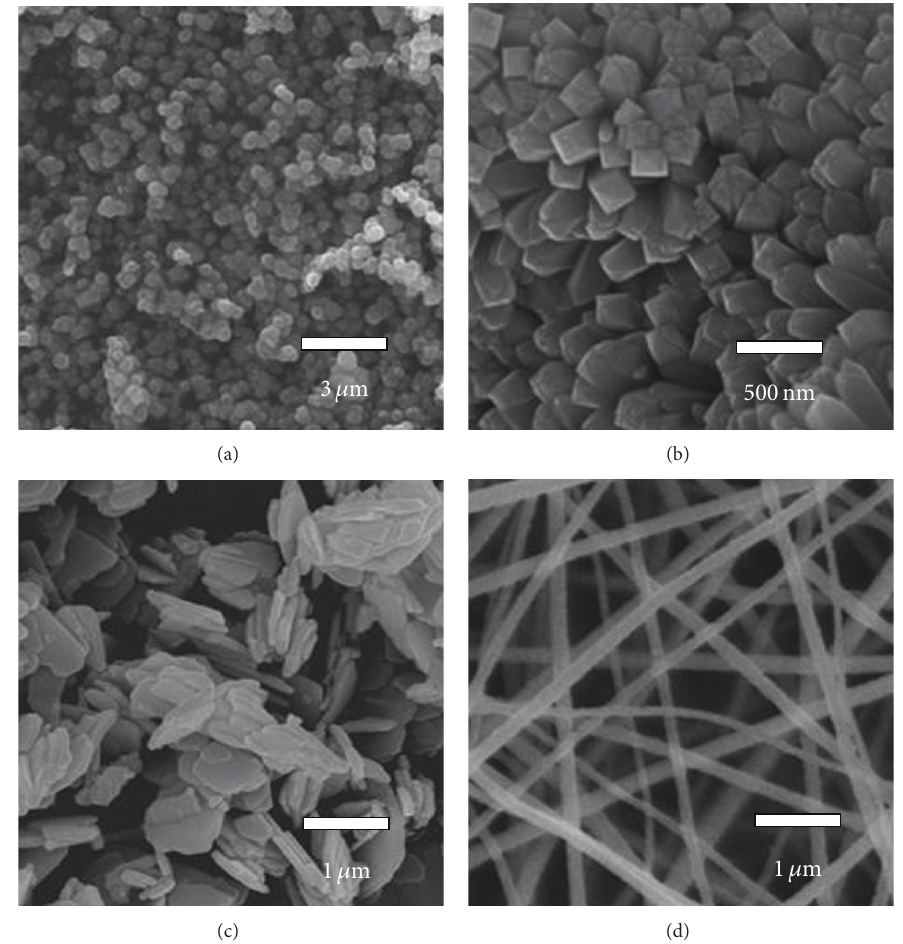
Figure 4: FESEM images of the prepared ZnO nanostructures: (a) sphere, (b) rod, (c) sheet, and (d)